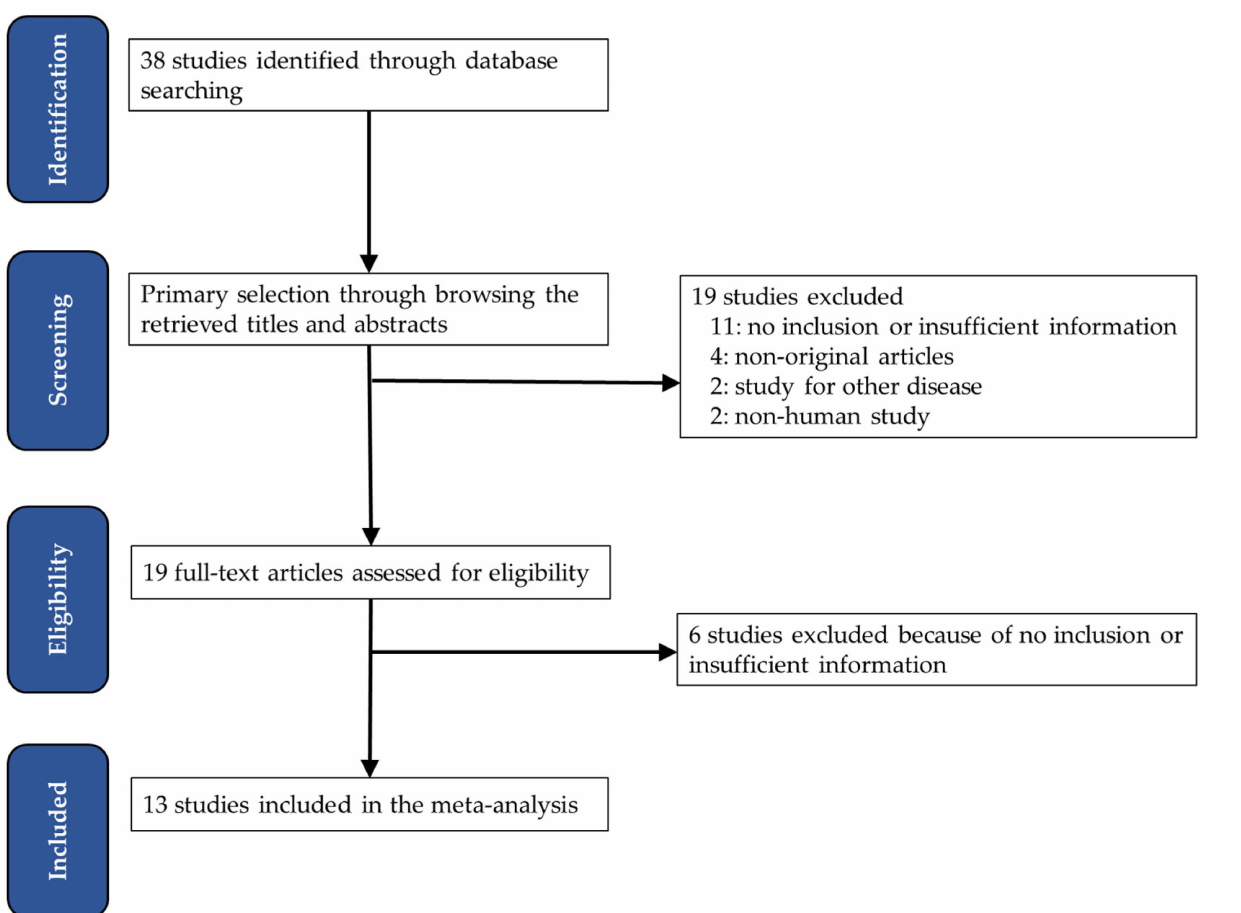
Figure 1. Flow chart of the searching